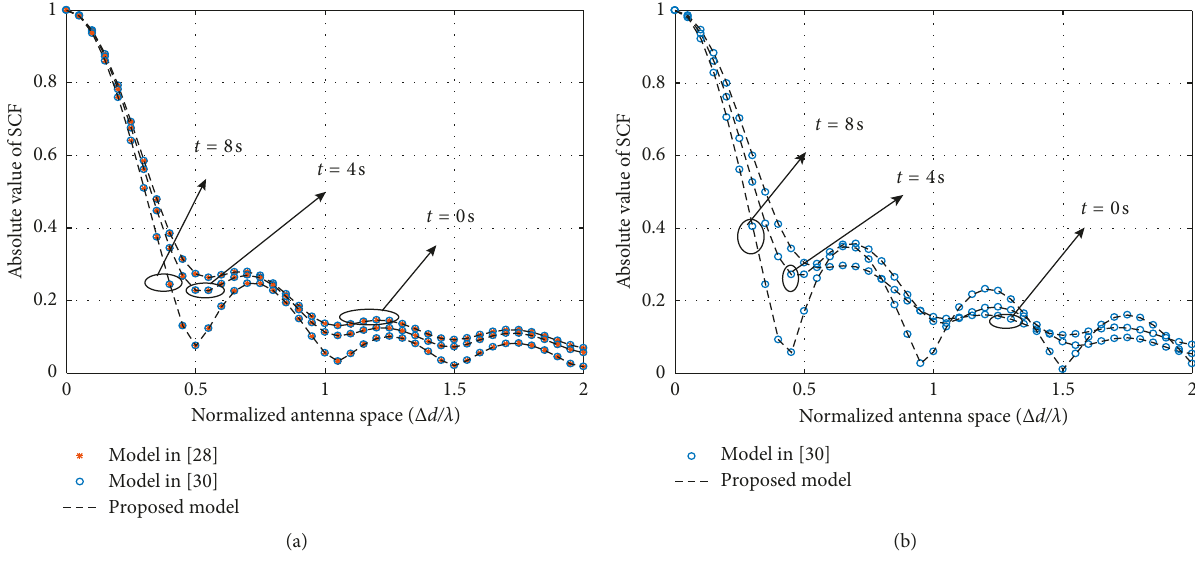
Figure 5: Comparison of absolute SCFs for (a) Path I and (b) Path